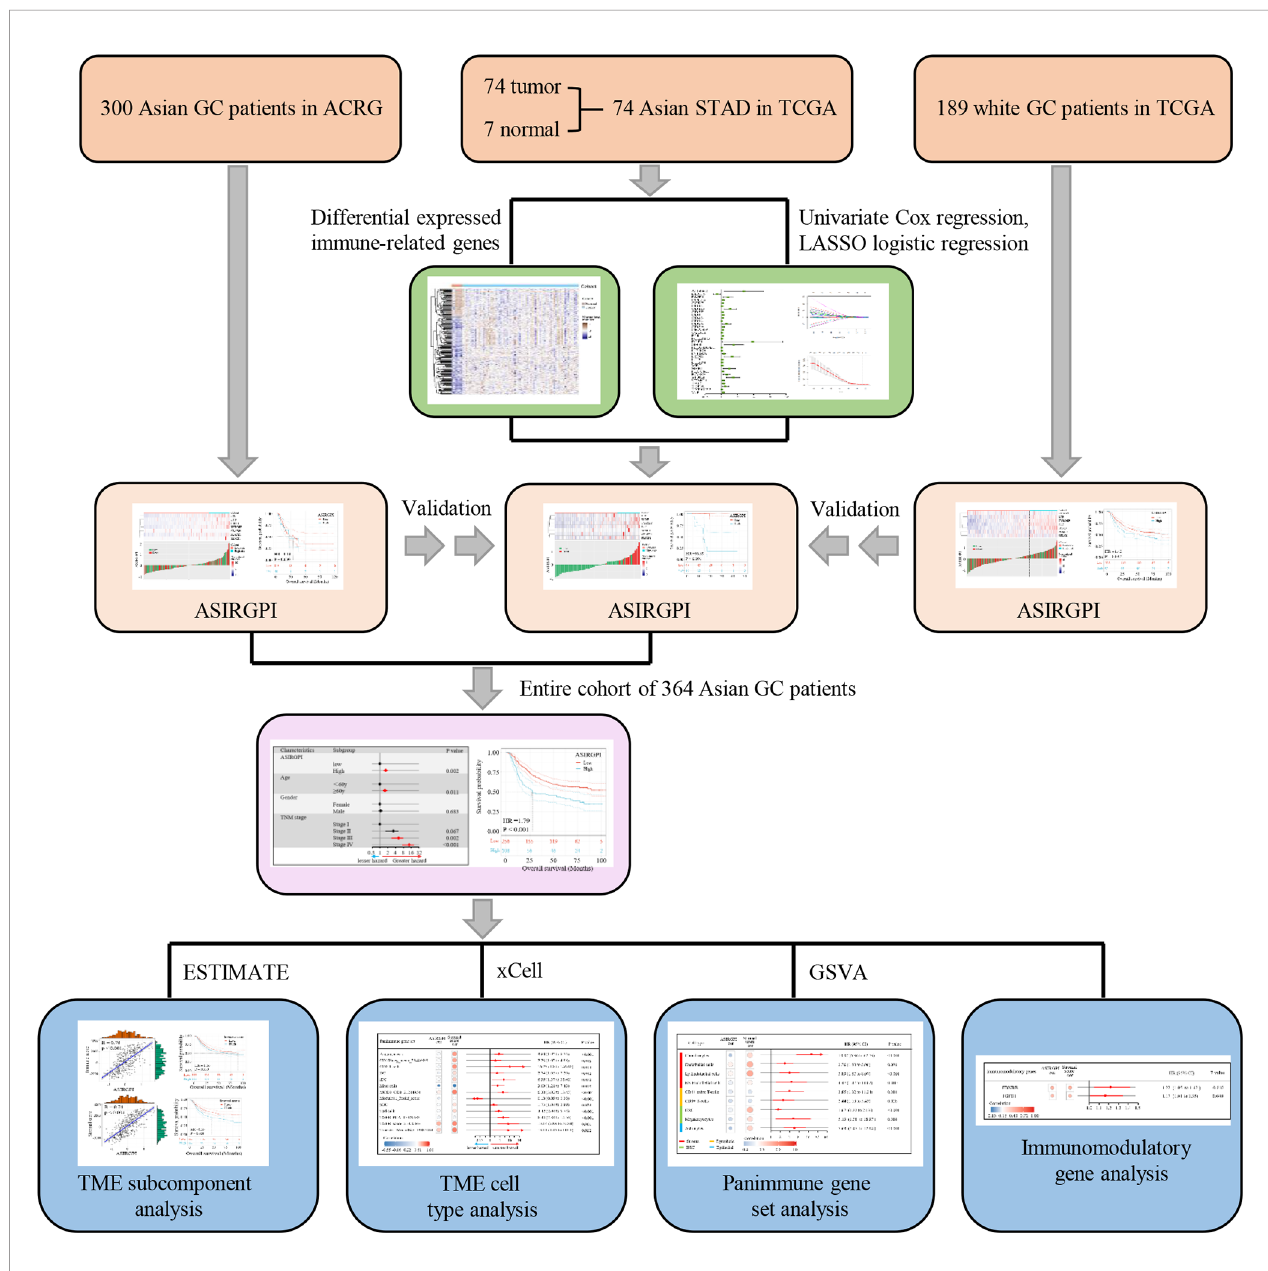
FIGURE 1 | Study fl